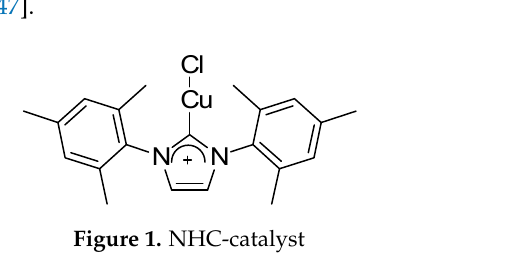
Table 2. Synthesis of triazoles by four sets of conditions (highest two trials per